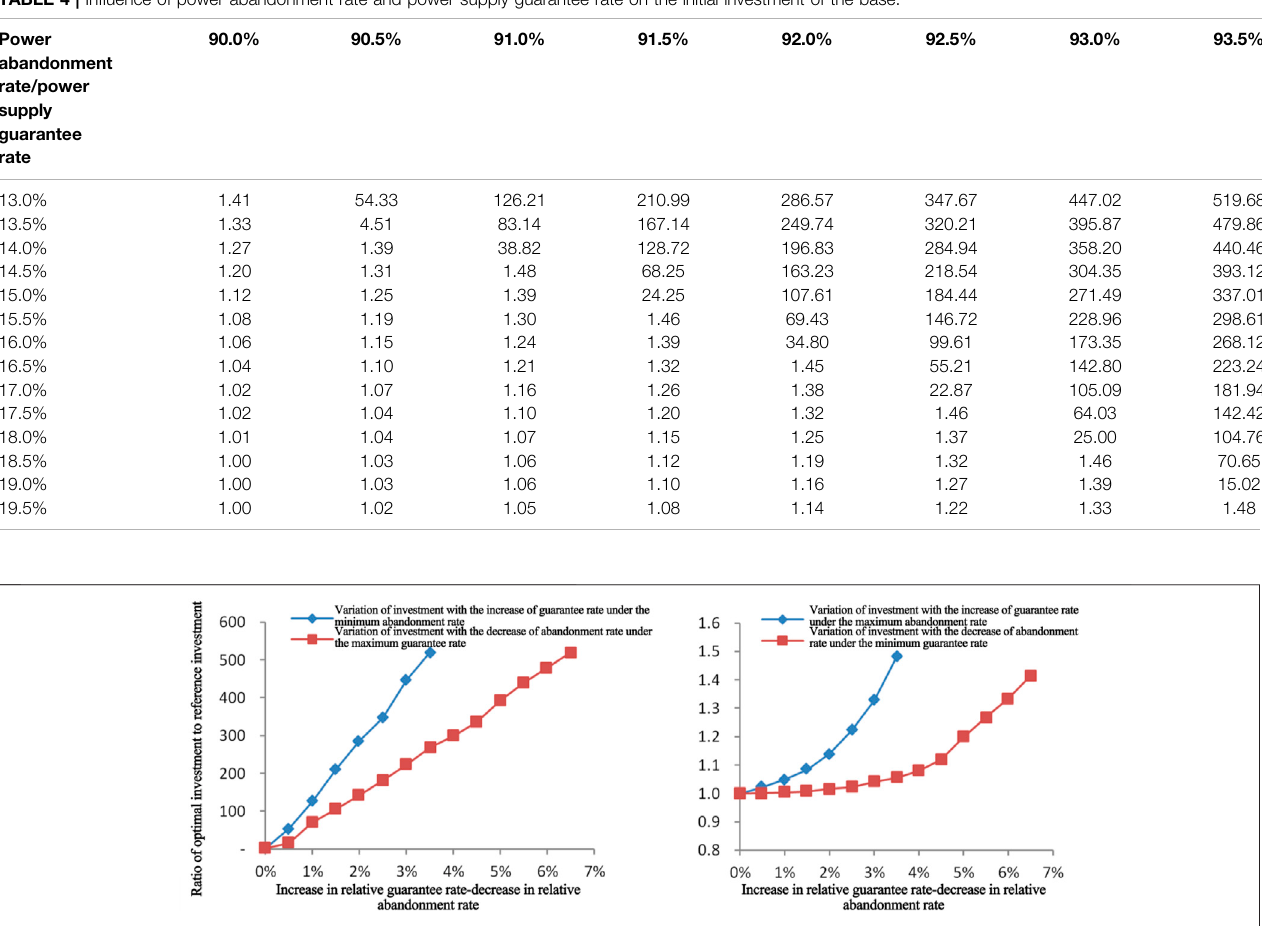
Frontiers in Energy Research |